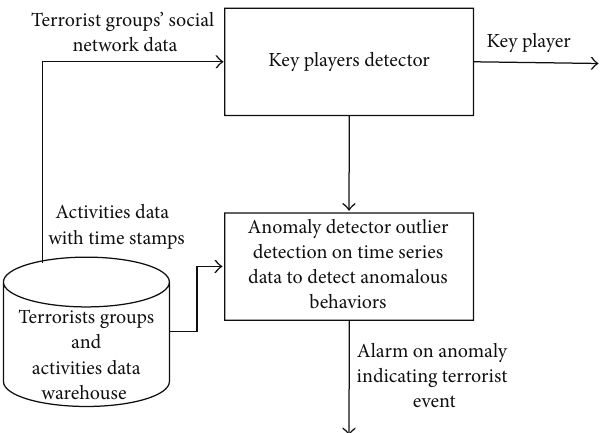
Figure 1: Flow diagram of proposed